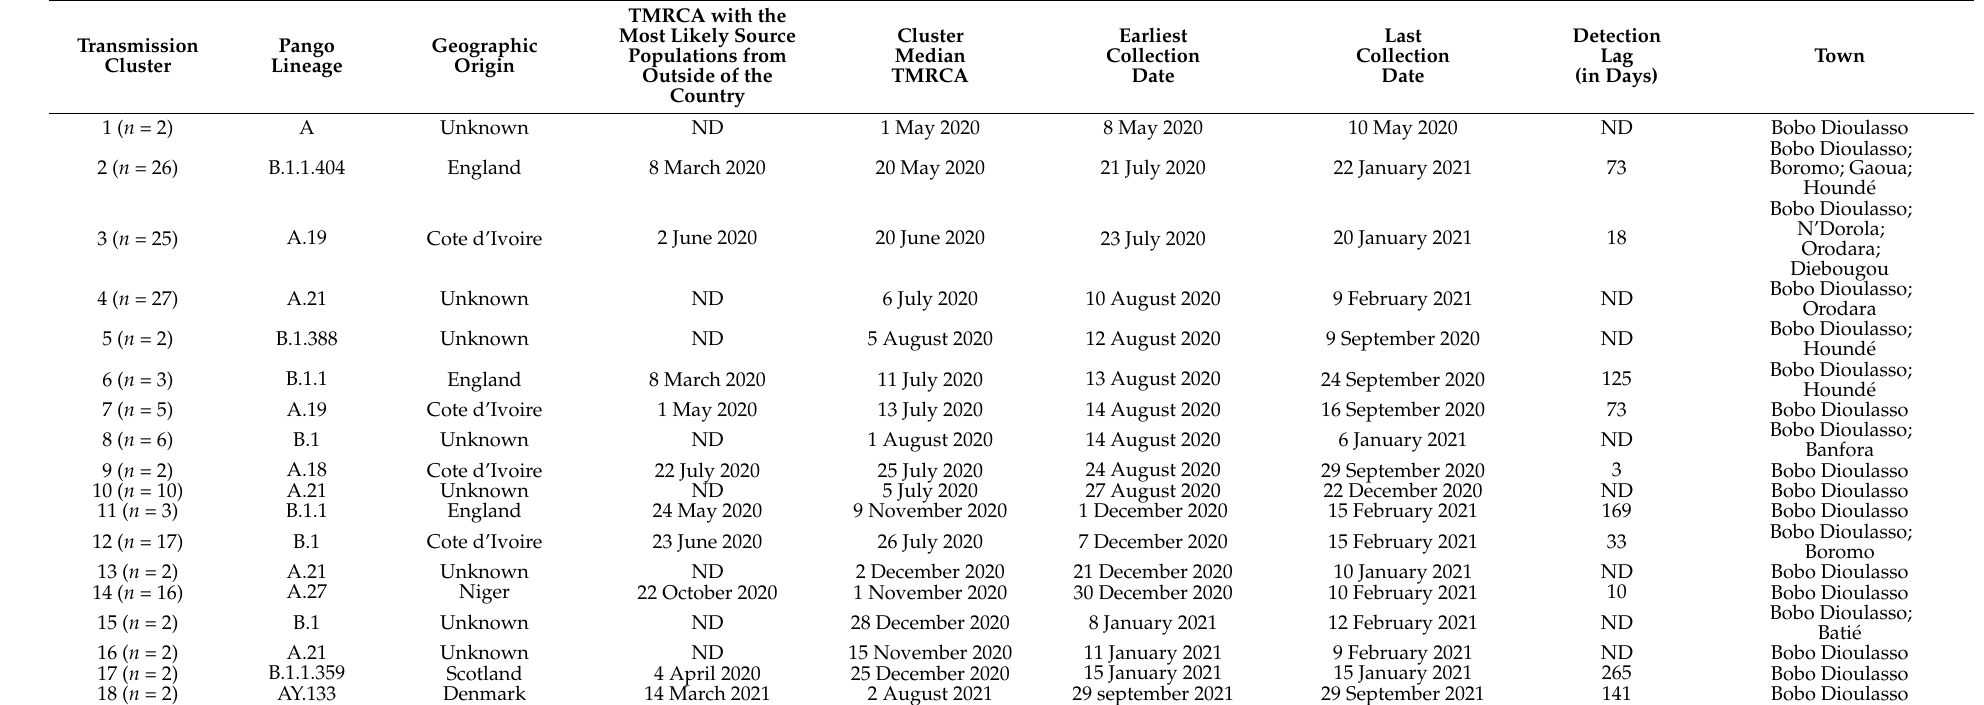
Table 1. Transmission clusters identified in western Burkina